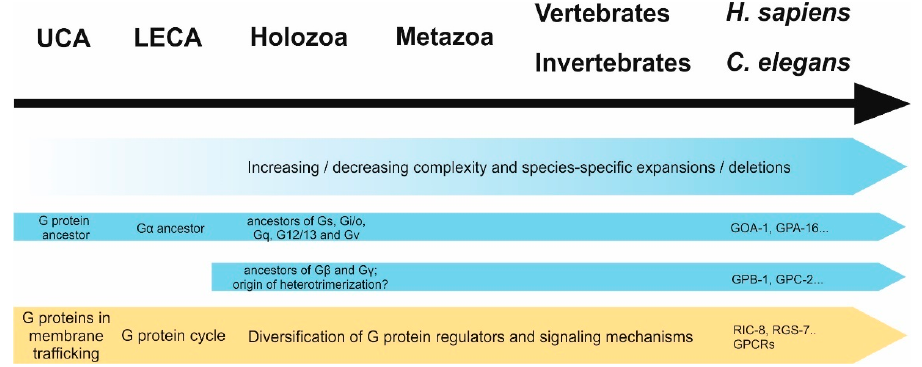
Figure 3. Development of G proteins (blue) and their functions (yellow) over time. First ancestors of G proteins and GPCRs have likely arisen in the universal common ancestor (UCA) of eukaryotes and prokaryotes, whereafter both underwent dramatic expansion and diversification. While the first appearance of a G α protein is thought to be in the last common eukaryotic ancestor (LECA), precursor proteins of human G α families as well as G β and G γ subunits seem to have diverted in holozoans, suggesting that G α could have had β / γ -independent functions pre-dating heterotrimerization. Before G proteins were recruited as downstream signals of membrane-bound receptors, they possibly functioned in membrane trafficking. Over time, not only their regulation through GEFs (such as GPCRs) but also other regulatory proteins (GAPs, GDIs) underwent expansion and gave rise to the multitude of G proteins signaling mechanisms we observe today.